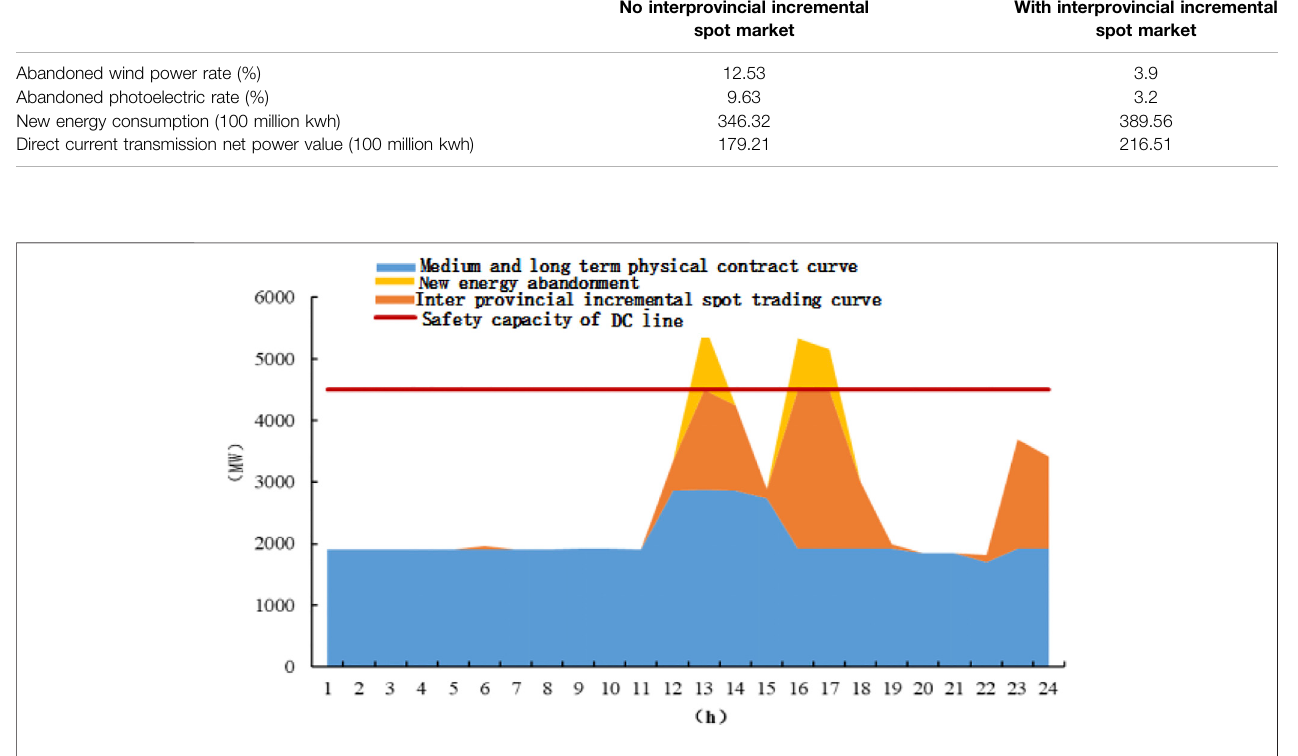
FIGURE 4 | Transmission power of the Gansu Qishao DC transmission